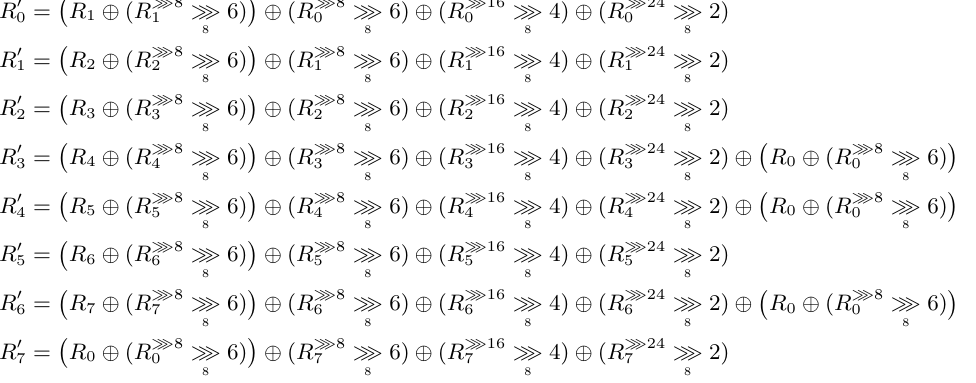
Figure 6: Equations to compute the MixColumns during the first fixsliced round where R i ≫ j refers to a byte-wise rotation of j bits to the right, for all bytes within R i . 8 Since ( R ≫ 16